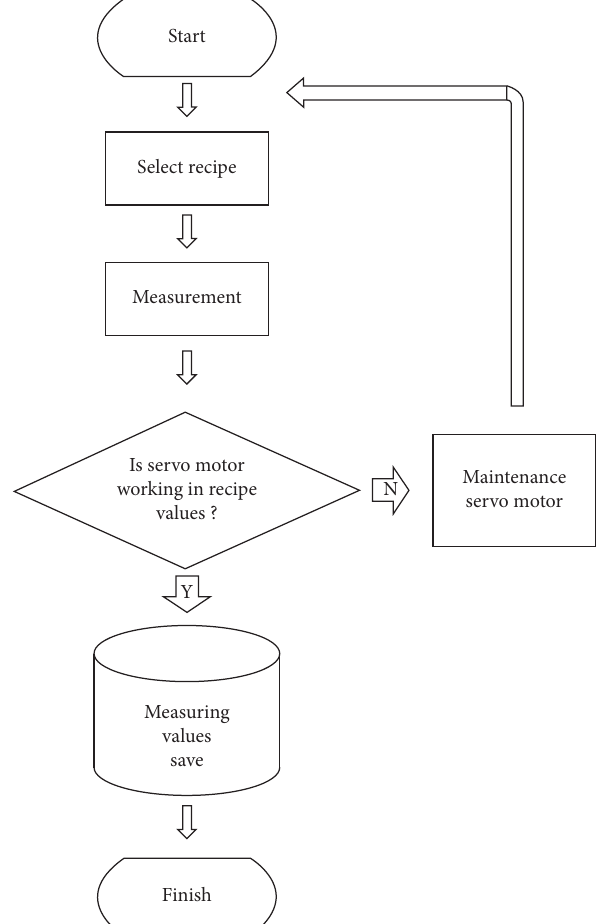
Figure 2: The operating algorithm of the